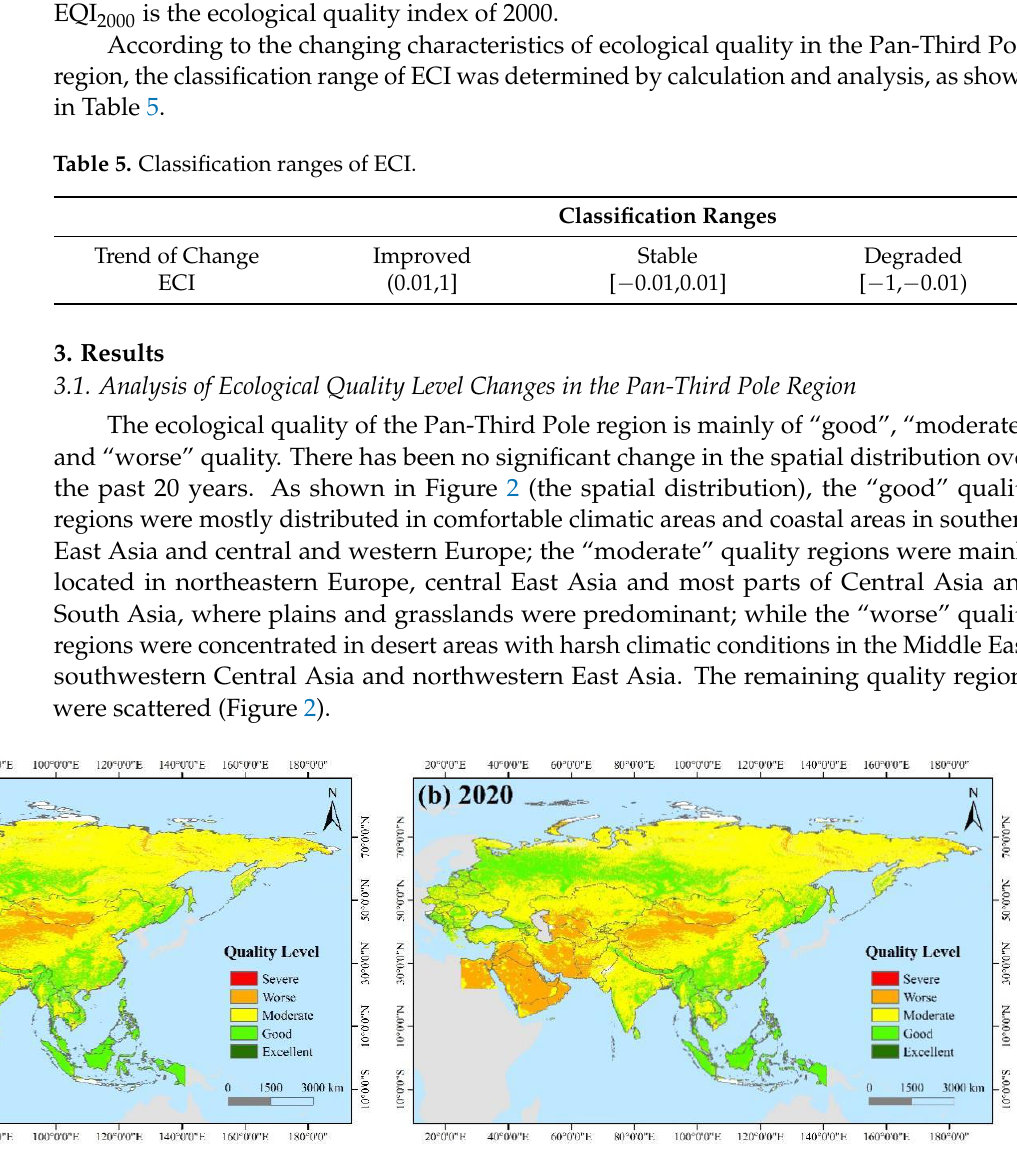
Figure 2. Spatial distribution of ecological quality levels in the Pan-Third Pole region ( a ) in 2000; ( b ) in 2020.